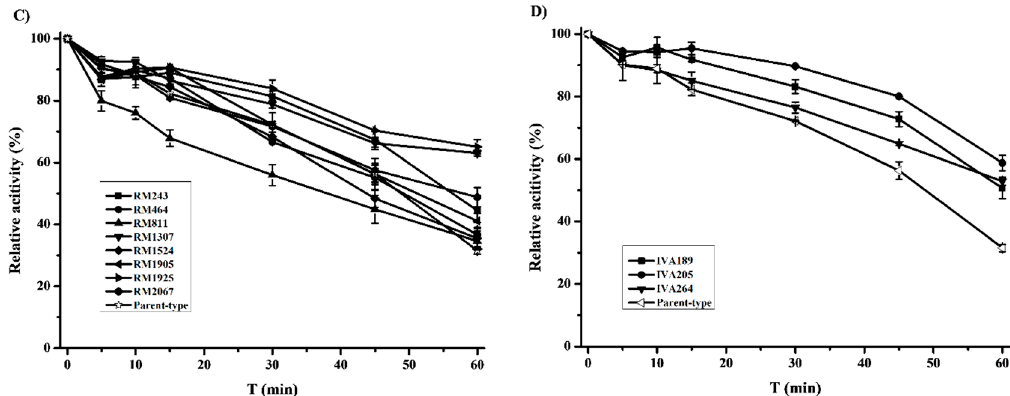
Figure 3. Effect of the evolved laccases on pH profile and thermostability. ( A ) pH profile of the evolved laccases from the random mutagenic library. ( B ) pH profile of the evolved laccases from the laccase library after in vivo assembly. ( C ) Thermostability of the evolved laccases from the random mutagenic library. ( D ) Thermostability of the evolved laccases from the laccase library after in vivo assembly. The results represent the mean ± standard deviation of duplicate independent experiments ( p < 0.01).